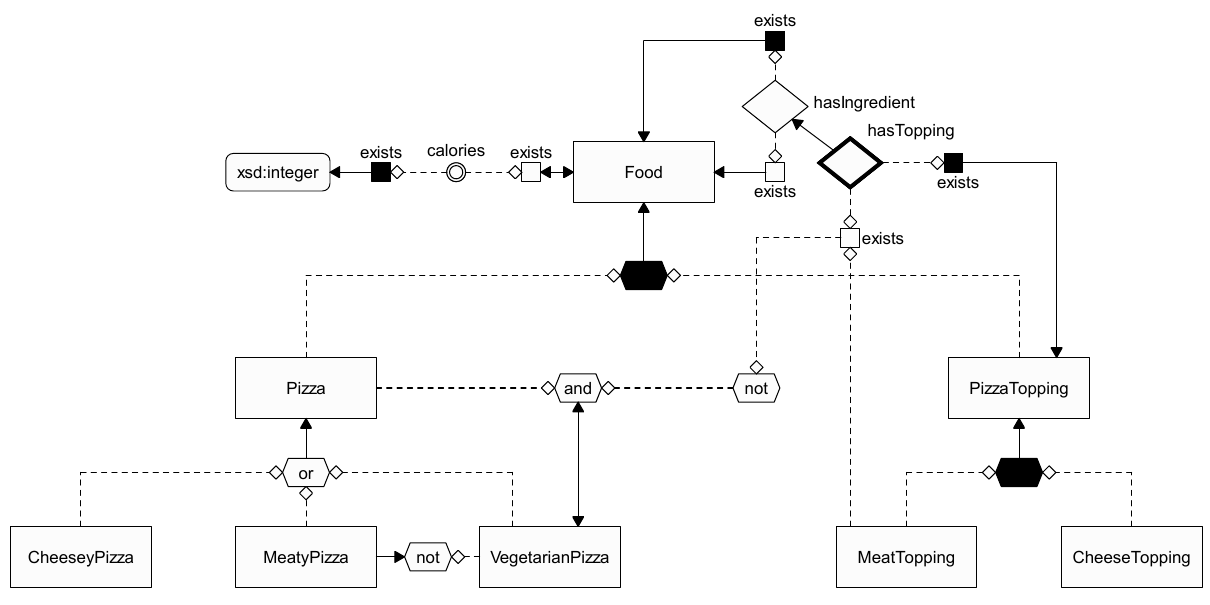
Figure 6. G RAPHOL ontology example: an excerpt of the Pizza